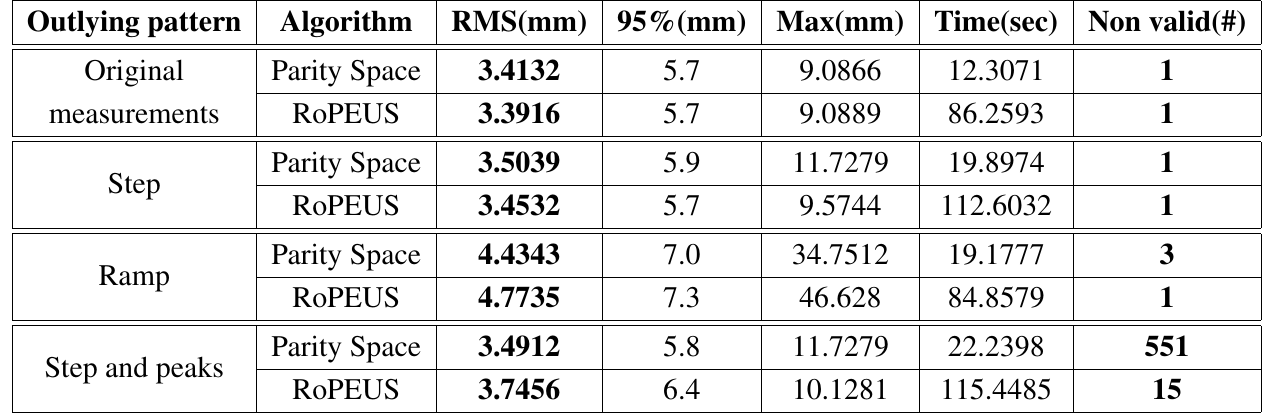
Table 4. Numerical results obtained when applying the PS and RoPEUS algorithm to the four cases studied (see Table